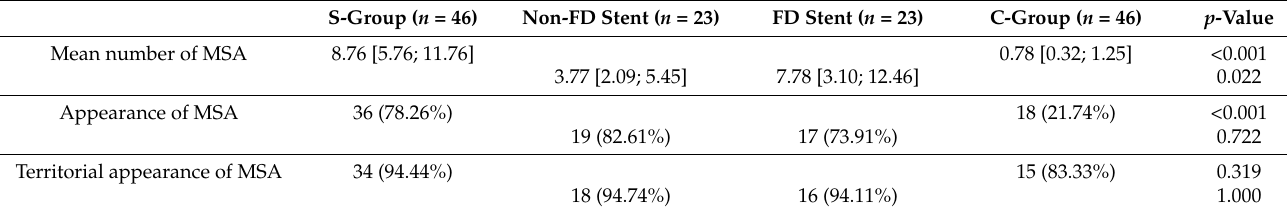
Table 2. Assessment of MSA in the different groups. Comparisons between the stent group (S-group) including non-flow diverter stent (non-FD stent) and FD ones (FD stent) and the coils group (C-group) in terms of the mean number of magnetic susceptibility artifacts (MSA) depicted in the last MRI of the follow-up. Appearance of MSA depicted when new MSA was noticed on a follow-up scan (only once for each patient) and territorial appearance of MSA depicting the preferential localization of previously appeared MSA in the arterial territory of the treated artery.